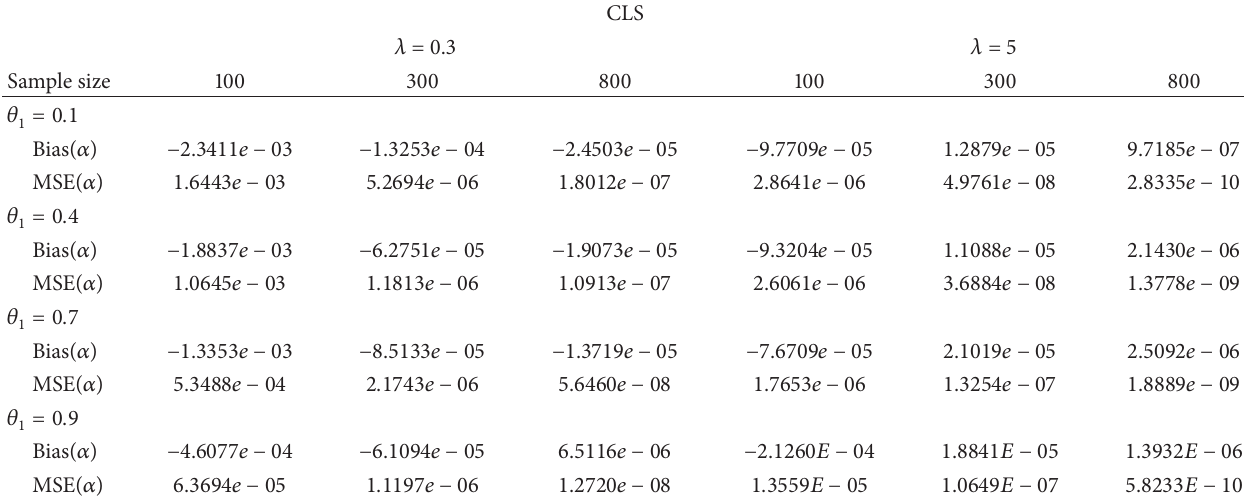
Table 1: Bias and MSE results of 𝛼 for NSINARMA(1,1)